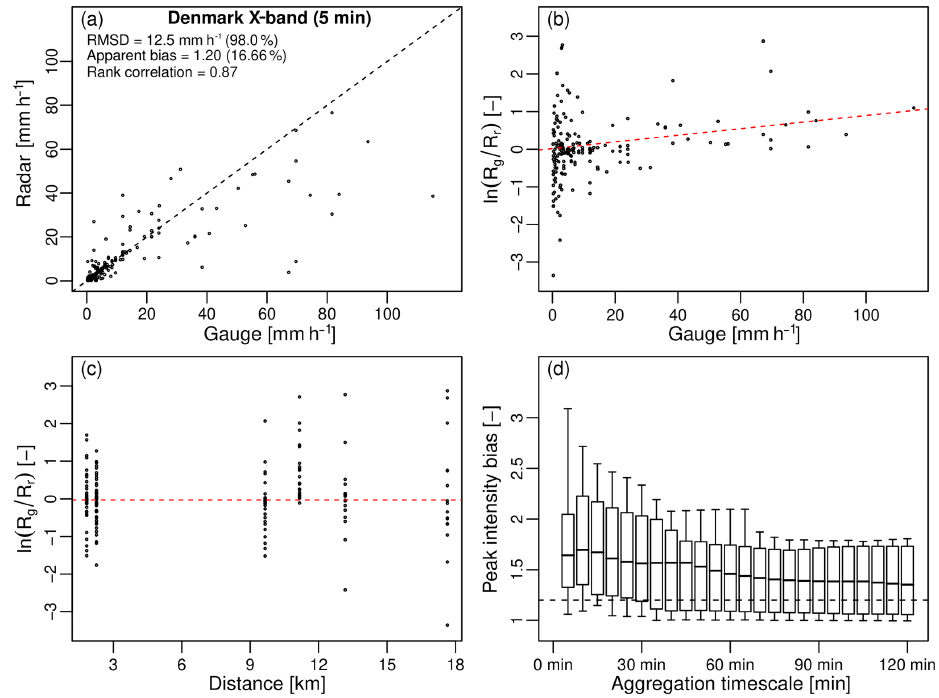
Figure 12. Performance metrics for the Danish X-band radar system (top 10